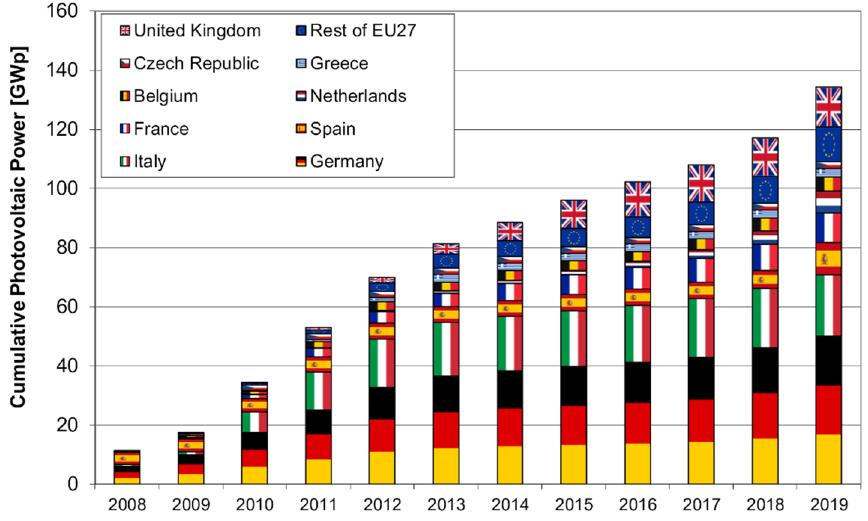
Figure 1. Grid-connected PV capacity in the EU and the United Kingdom [12,13].